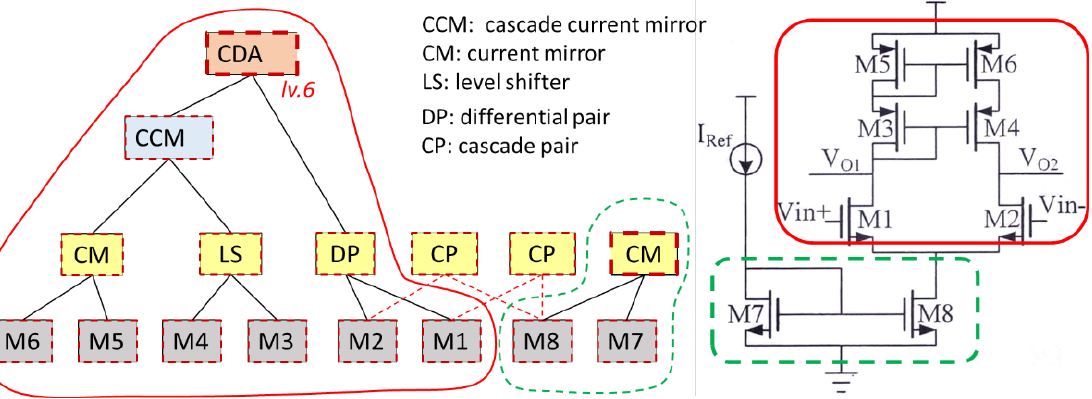
Figure 10. Structure recognition result of CDA with a CM.